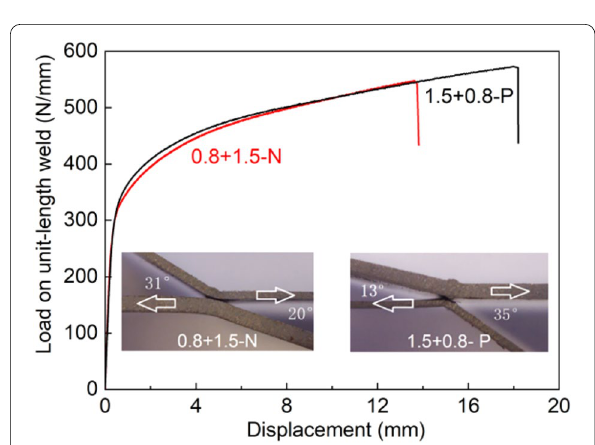
Figure 4 Tensile shear curves of two laser welded joints